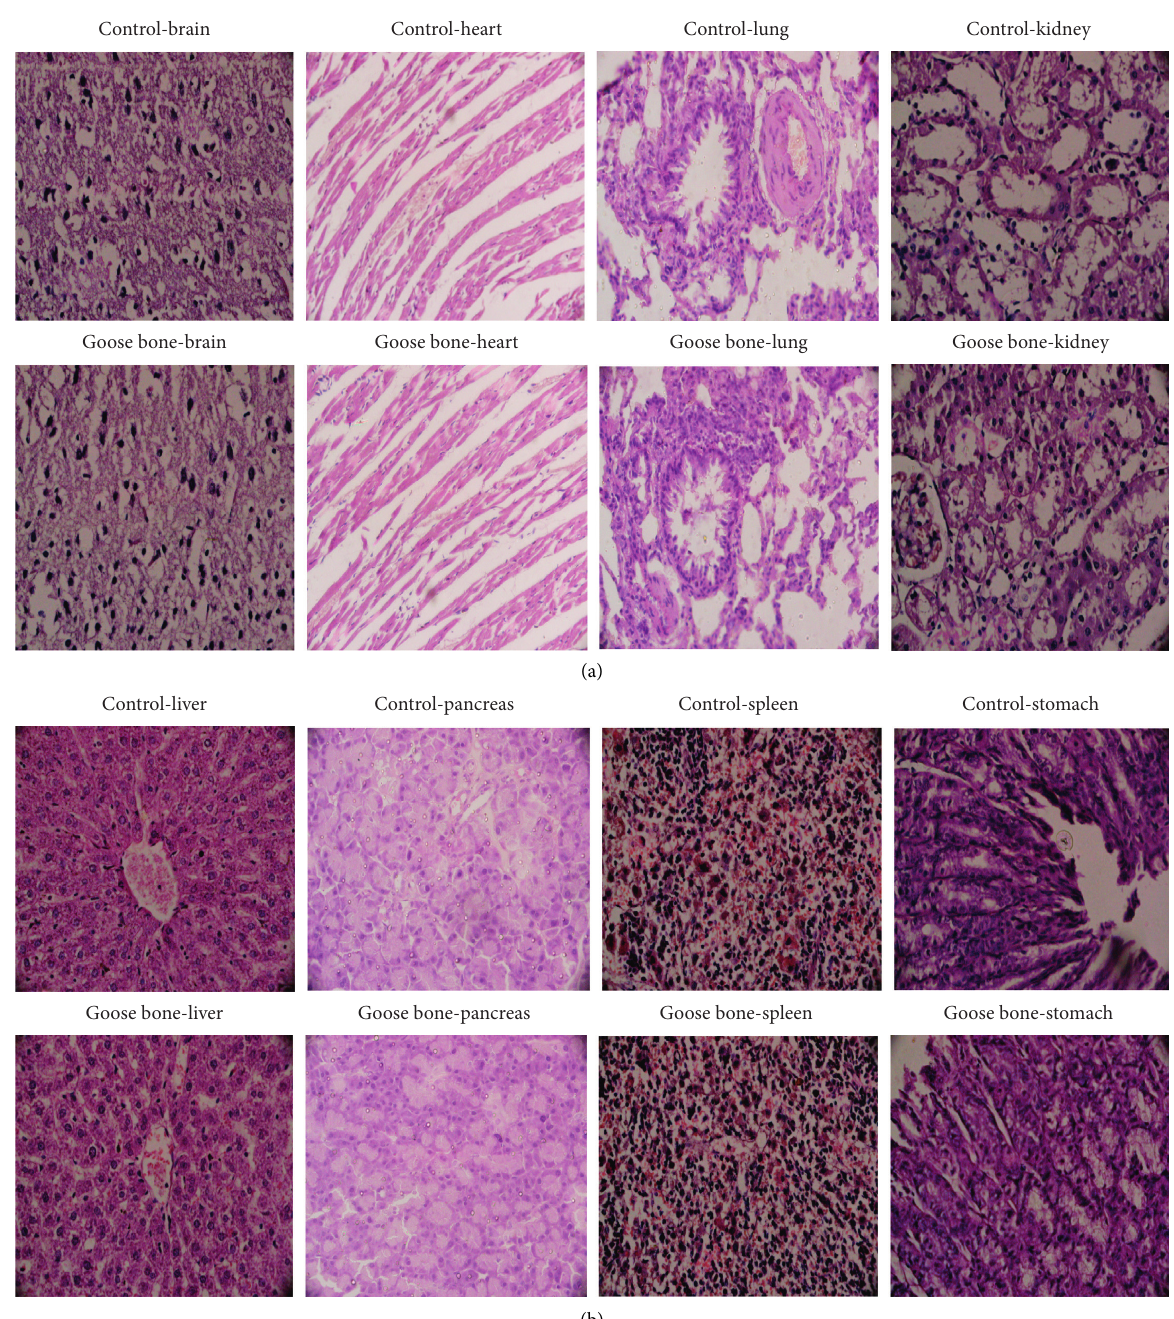
Figure 4: Histopathological photomicrographs of control and treatment groups (120mg/kg) (40x magnification, scale bar: 20 μ m). No morphological and pathological changes were observed between the control and goose bone-administered